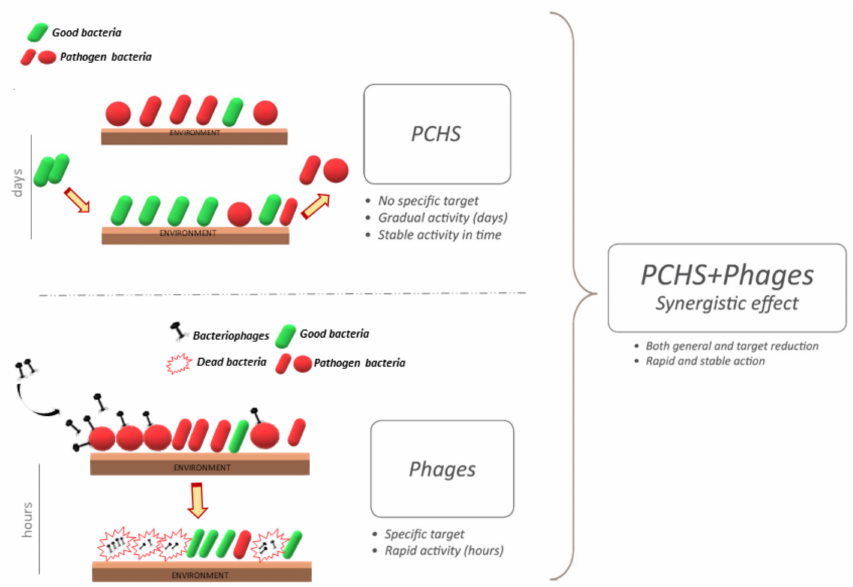
Figure 2. Schematic representation of combined cleaning system including a probiotic-based de- tergent additioned with bacteriophages. The probiotic component is characterized by a slow and gradual action, based on a mechanism based on competitive exclusion, remodulating the microbiome in a slow and gradual activity. Treatment is more rapid and